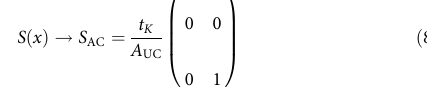
graphene from some initial reference stacking due to, for example, a series of partial dislocations. For the case of a single type, three partial dislocation such a